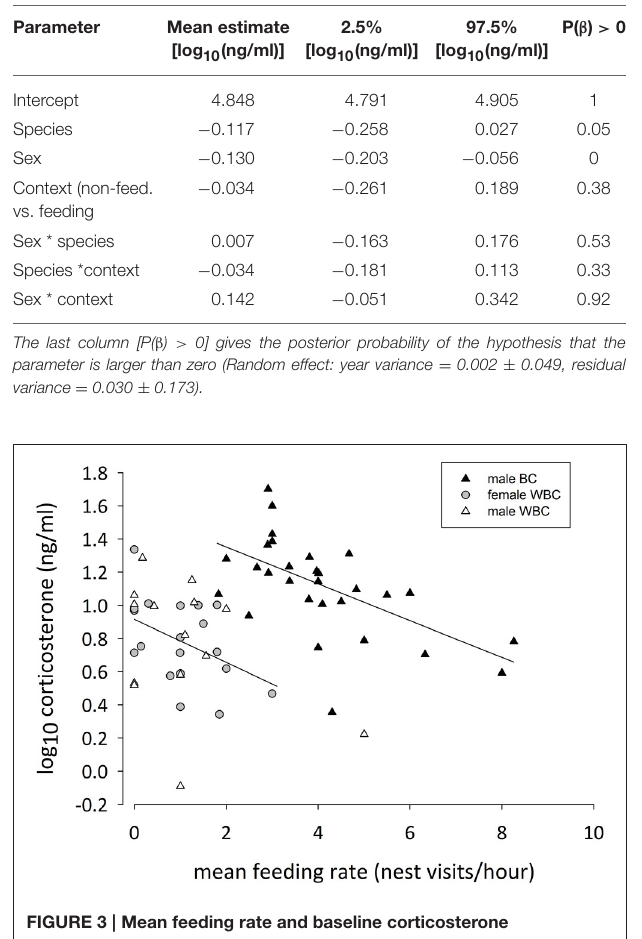
did not influence baseline corticosterone in male white-browed coucals (log 10 slope: − 0.29 [ − 0.68 to 0.11]; P( β ) = 0.07),